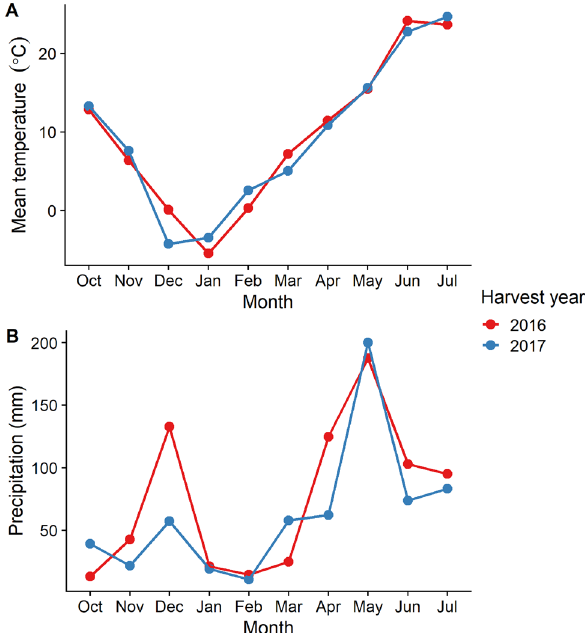
Figure 5. Monthly mean temperature ( A ) and total precipitation ( B ) during the 2016 (2015–2016) and 2017 (2016–2017) winter wheat harvest years at the Eastern Nebraska Research and Extension Center (ENREC) near Mead, NE, USA. Data collected from the Automated Weather Data Network of the High Plains Regional Climate Center 32 ; plot generated using the ‘ggplot2’ and ‘cowplot’ packages in R 38,40,41